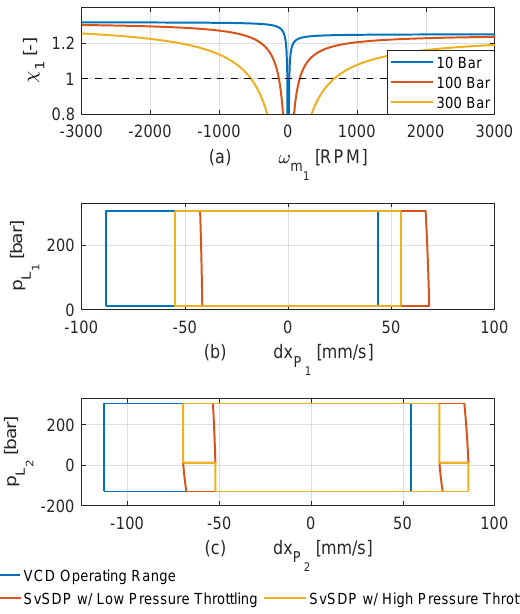
Figure 9: (a) Match ratio for the selected pump com- bination. (b) Operating range for SvSDP 1 compared to VCD. (c) Operating range for SvSDP 2 compared to VCD.